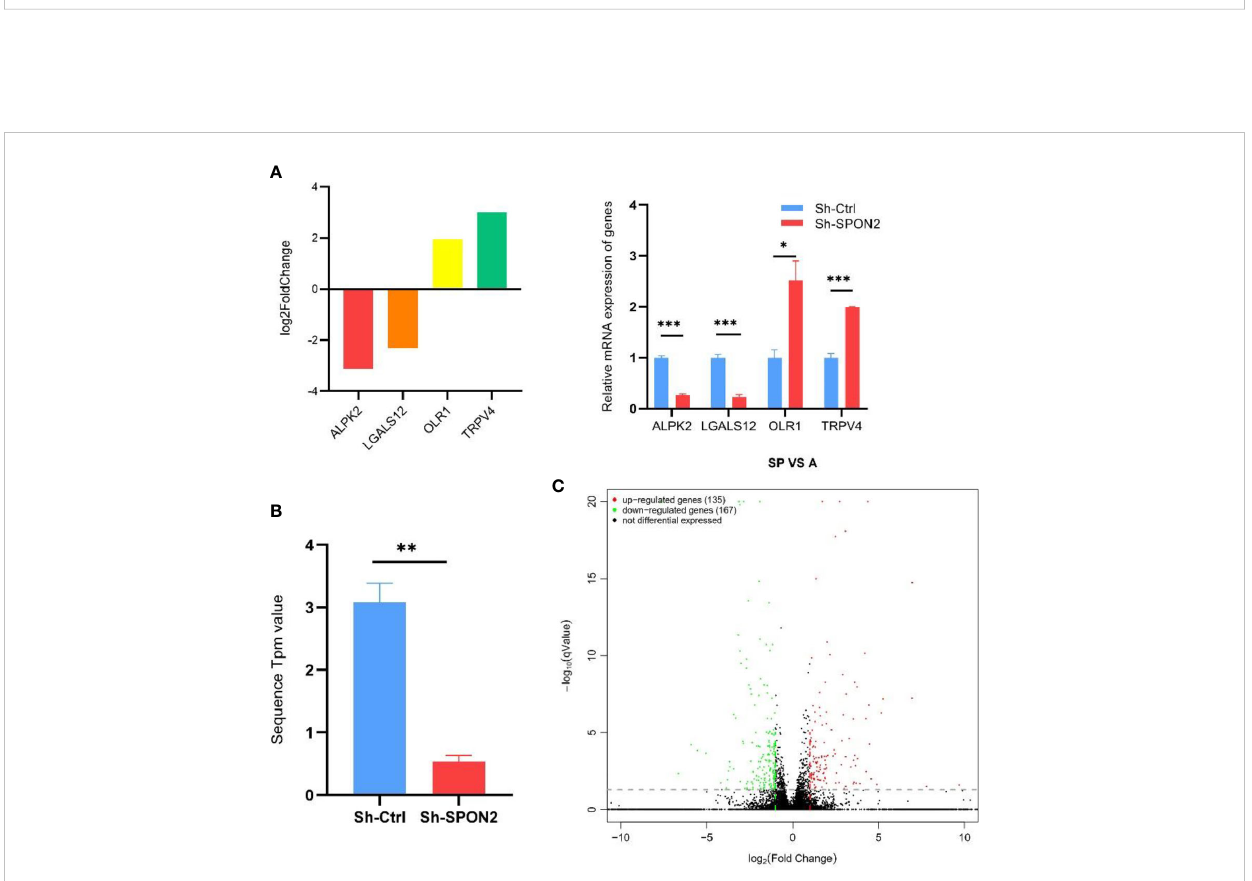
FIGURE 6 Transcriptome sequencing after knockdown of SPON2 in MDA-MB-231 cells. (A) Four transcriptome sequencing differential genes were randomly selected for qPCR validation, and the results showed that qPCR and transcriptome sequencing validated the differential gene expression trends in agreement. (B) Transcriptome sequencing showed that the SPON2 knockdown group (Sh-SPON2) had lower SPON2 expression than the control virus group (Sh-Ctrl). (C) The transcriptome sequencing volcano map showed that knockdown of SPON2 resulted in upregulation of 135 genes and downregulation of 167 genes. * P < 0.05, ** P < 0.01, *** P <